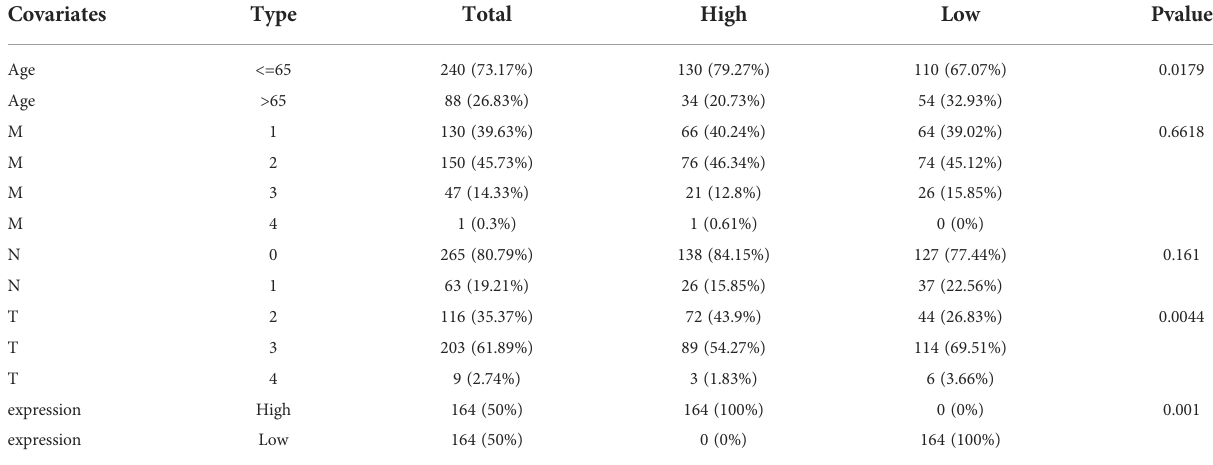
TABLE 3 AP004608.1 gene expression and clinical indicators correlation analysis.